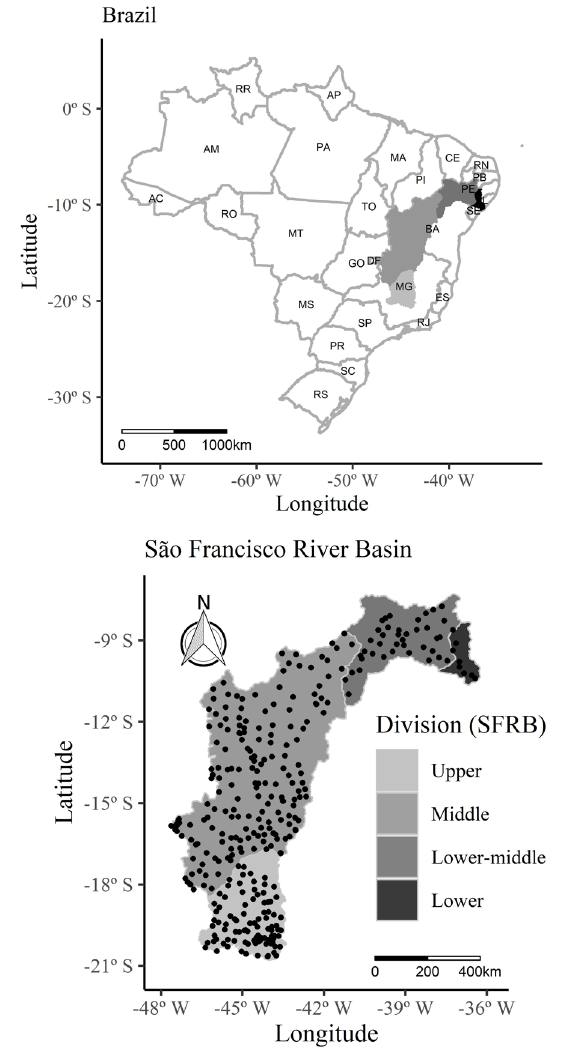
Figure 1. Map of São Francisco River Basin (SFRB) and distribution of the 341 pluviometric